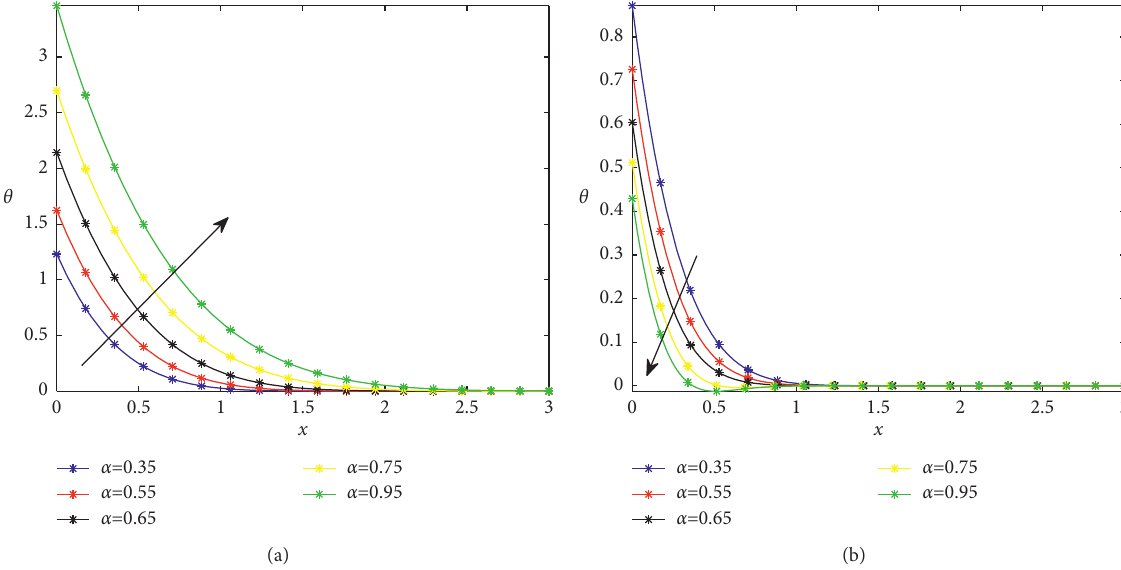
Figure 2: Concentration for different values of the order α . We observe that when τ � 4 and the order of the Caputo derivative increases, the concentration of our considered model increases as well. In contrast, when τ � 0 . 4, we notice the increase in the order of the fractional operator generates a decrease in the concentration. The previous behaviors are confirmed when the Schmidt number Sc � 10; see Figures 2(a), and 2(b). Finally, the order of the Caputo derivative has an acceleration or retardation effect that depends on the considered times. These behaviors are explained by the accumulation of the memory effect when the order of the Caputo derivative